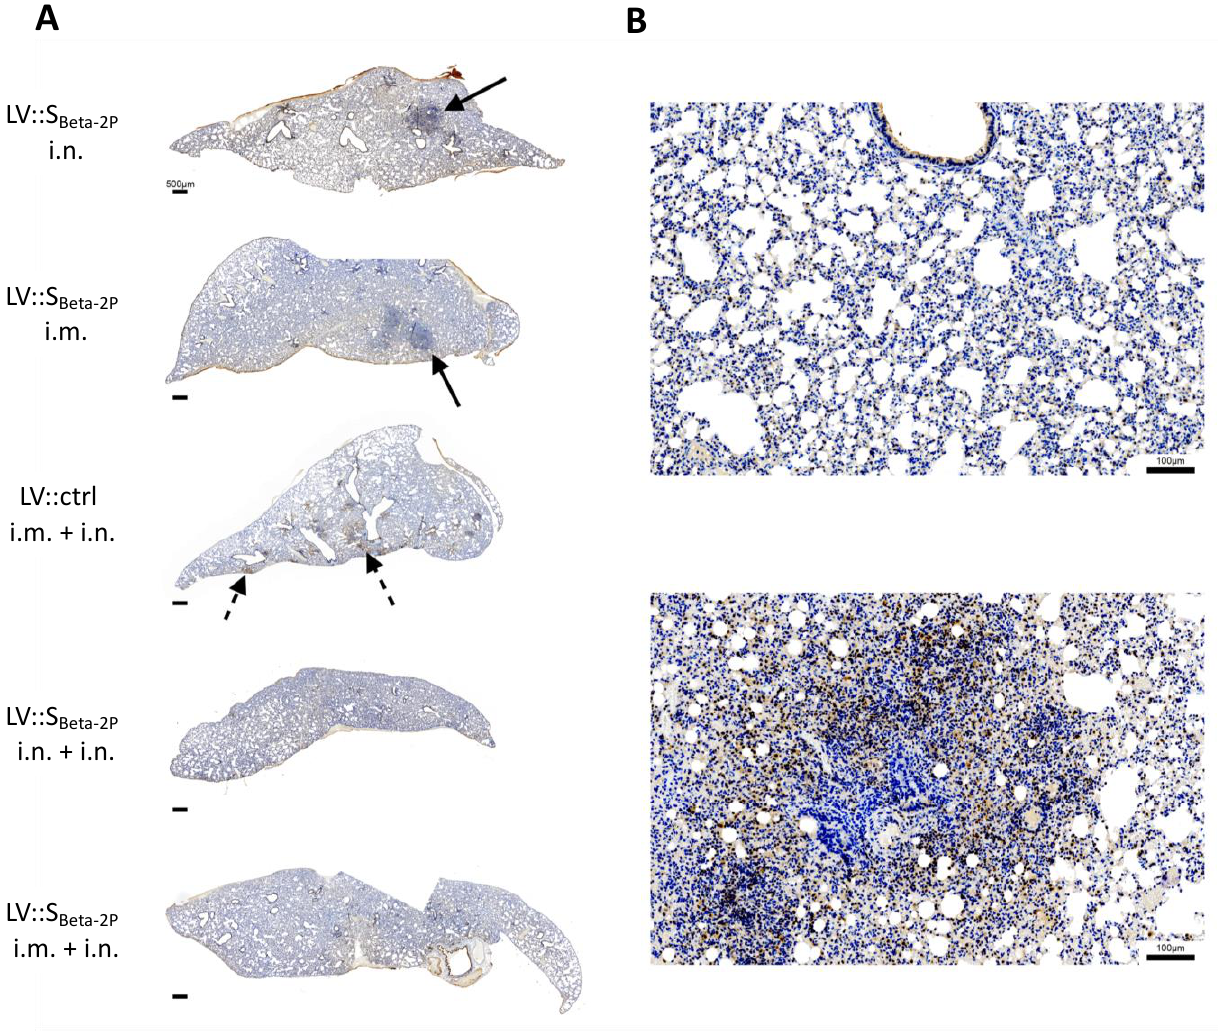
Figure 6. Immunodetection of the NCoV-2 antigen performed on lungs of Omicron SARS-CoV-2- infected hamsters. Hamsters are those described in Figure 5. ( A ) One example of each vaccination regimen is shown at low magnification. Solid arrows denote foci of inflammatory infiltrates, and dotted arrows areas where the immunodetection signal is discernable even at this low magnification. ( B ) The close-up views depict the concentration of viral antigen (brown) within the inflammatory foci ( bottom ), while areas harboring no or little inflammation ( top ) display only scarce staining. Altogether, these results showed that while a single i.n. immunization with LV can be enough to control the infection, an LV-based i.n. administration will be better adapted to boost a previously induced anti-COVID-19 immunity.